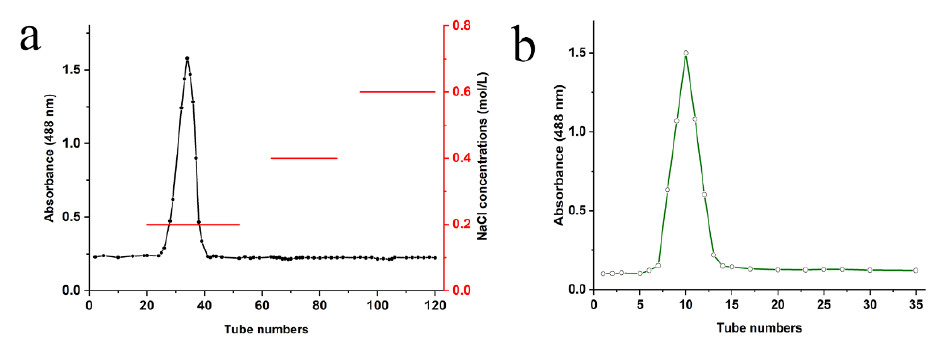
Figure 1. Chromatography of Pan purified via DEAE-52 chromatography ( a ) and Sephadex G-200 ( b